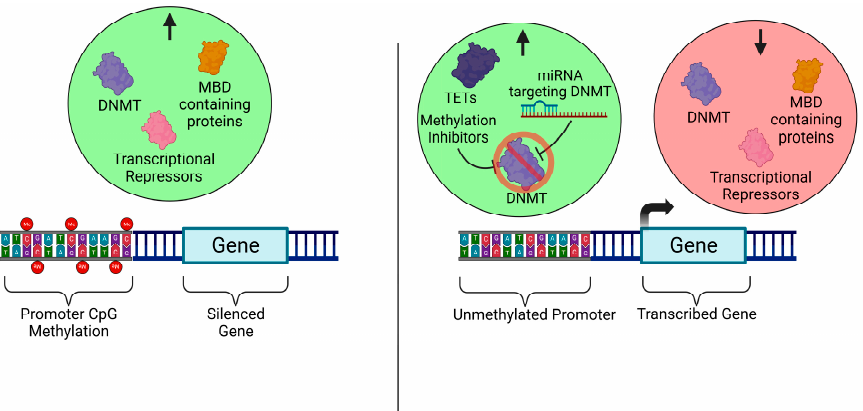
Figure 2. Regulators of DNA methylation. CpG methylation and the factors involved in writing (DNMT), reading (MBD containing proteins) and executing the silencing of genes (repressors). This mark is able to be removed or inhibited by the activity of DNA hydroxymethylases (TETs) and miRNA targeting DNMT. Receptor Activator of Nuclear Factor-kappa B (RANK).